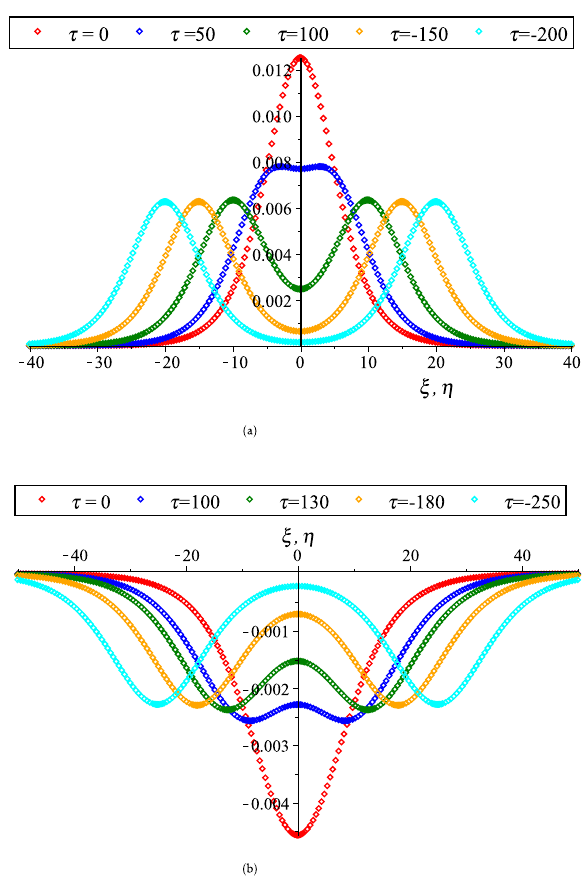
φ l = φ ( 1 ) l (ξ , τ) + φ ( 1 ) r (η , τ) structures with different values of time due to (cid:31) (cid:30)